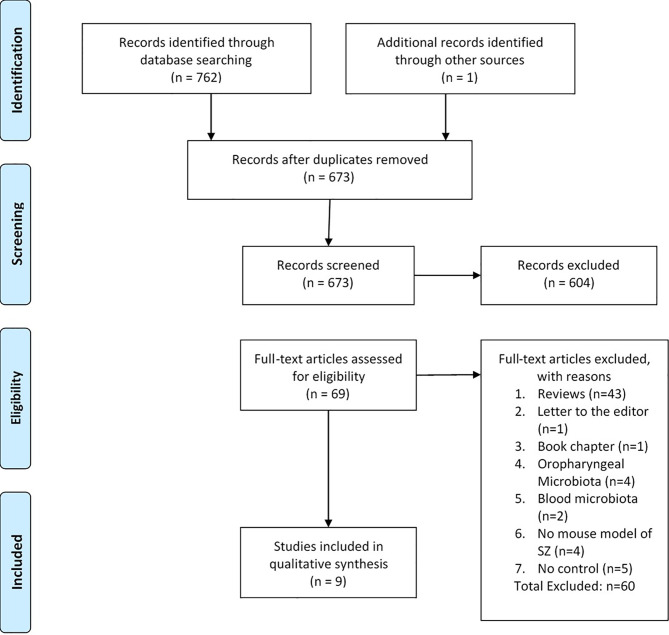
Flow diagram (47).